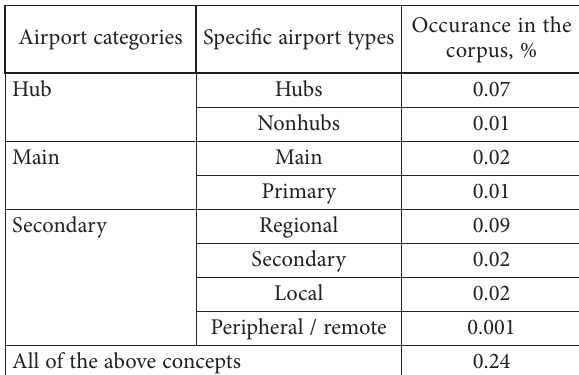
Table 3. Distribution of airport types in the corpus